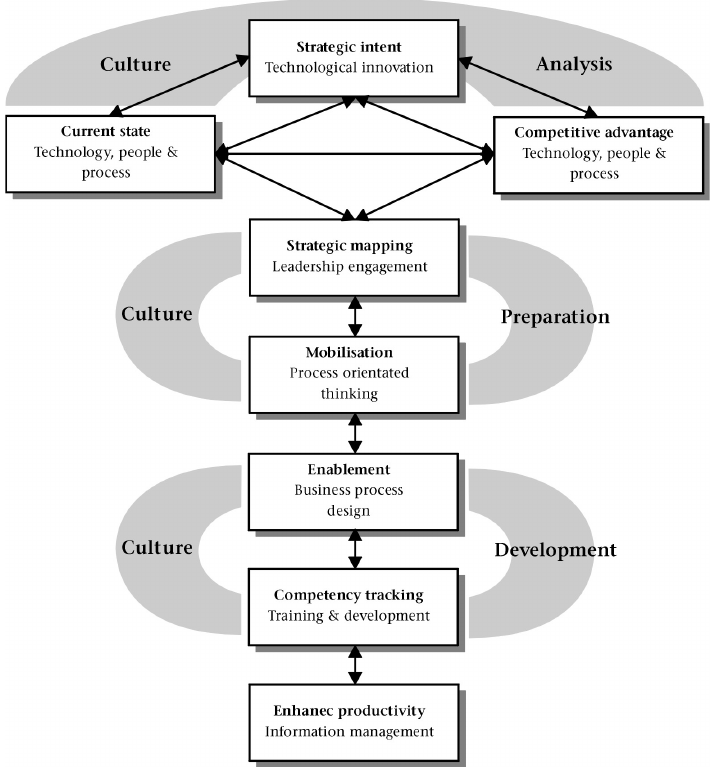
Figure 1: High level summary of core